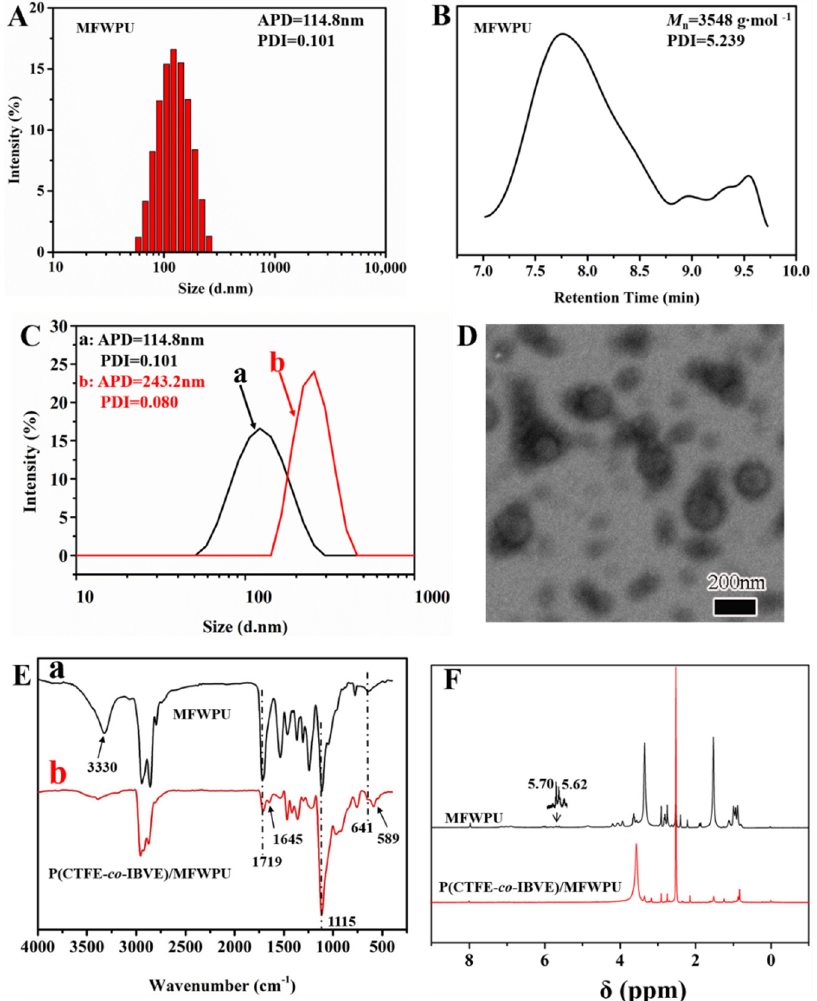
Figure 2. ( A ) Particle size distribution histogram and ( B ) GPC curve of MFWPU. ( C ) Particle size distribution of MFWPU ( a ) and P(CTFE- co -IBVE)/MFWPU composite particles ( b ). ( D ) SEM micrograph of P(CTFE- co -IBVE)/MFWPU composite particles. ( E ) FTIR spectra of MFWPU ( a ) and P(CTFE- co -IBVE)/MFWPU composite particles ( b ). ( F ) 1 H NMR spectra of MFWPU and P(CTFE- co -IBVE)/MFWPU composite particles.